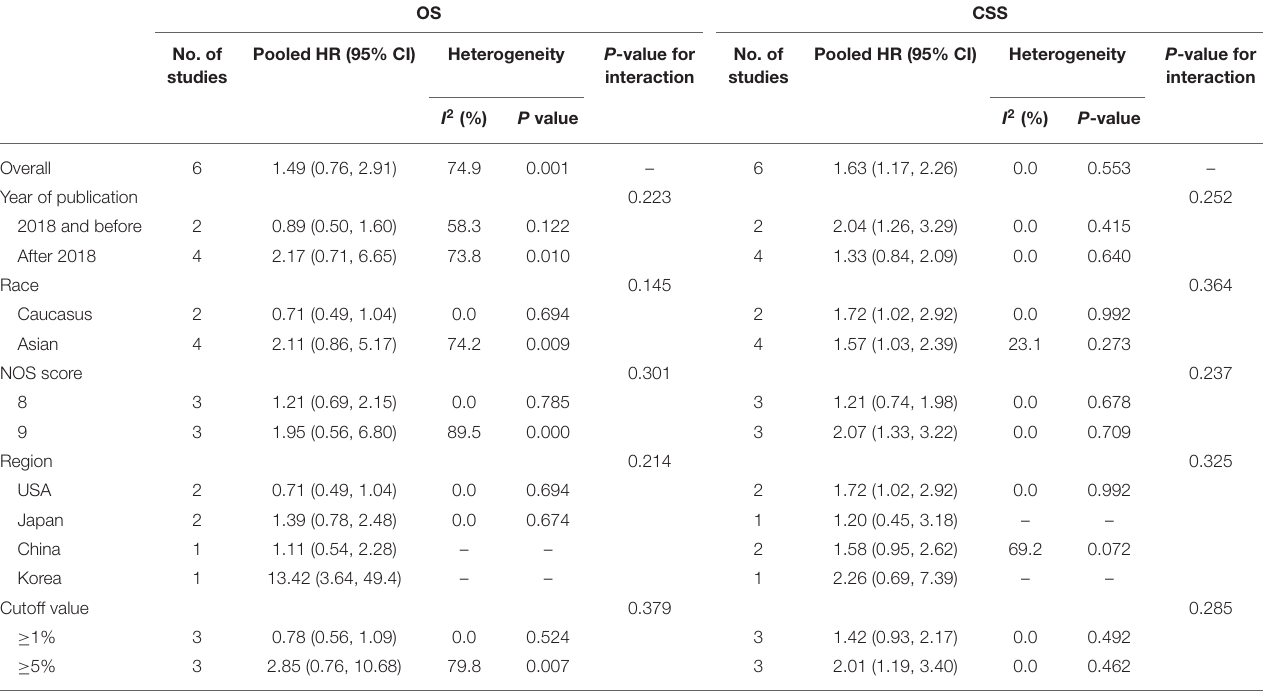
TABLE 2 | Subgroup analyses between PD-L1 expression and survival outcomes. OS